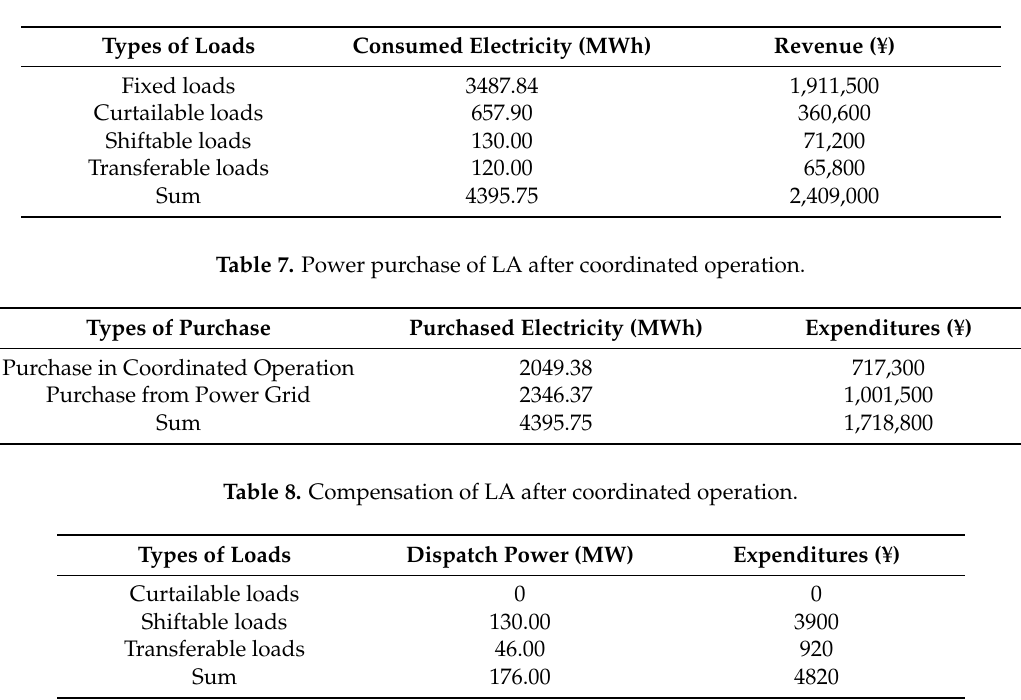
Table 6. LA revenue after coordinated operation.